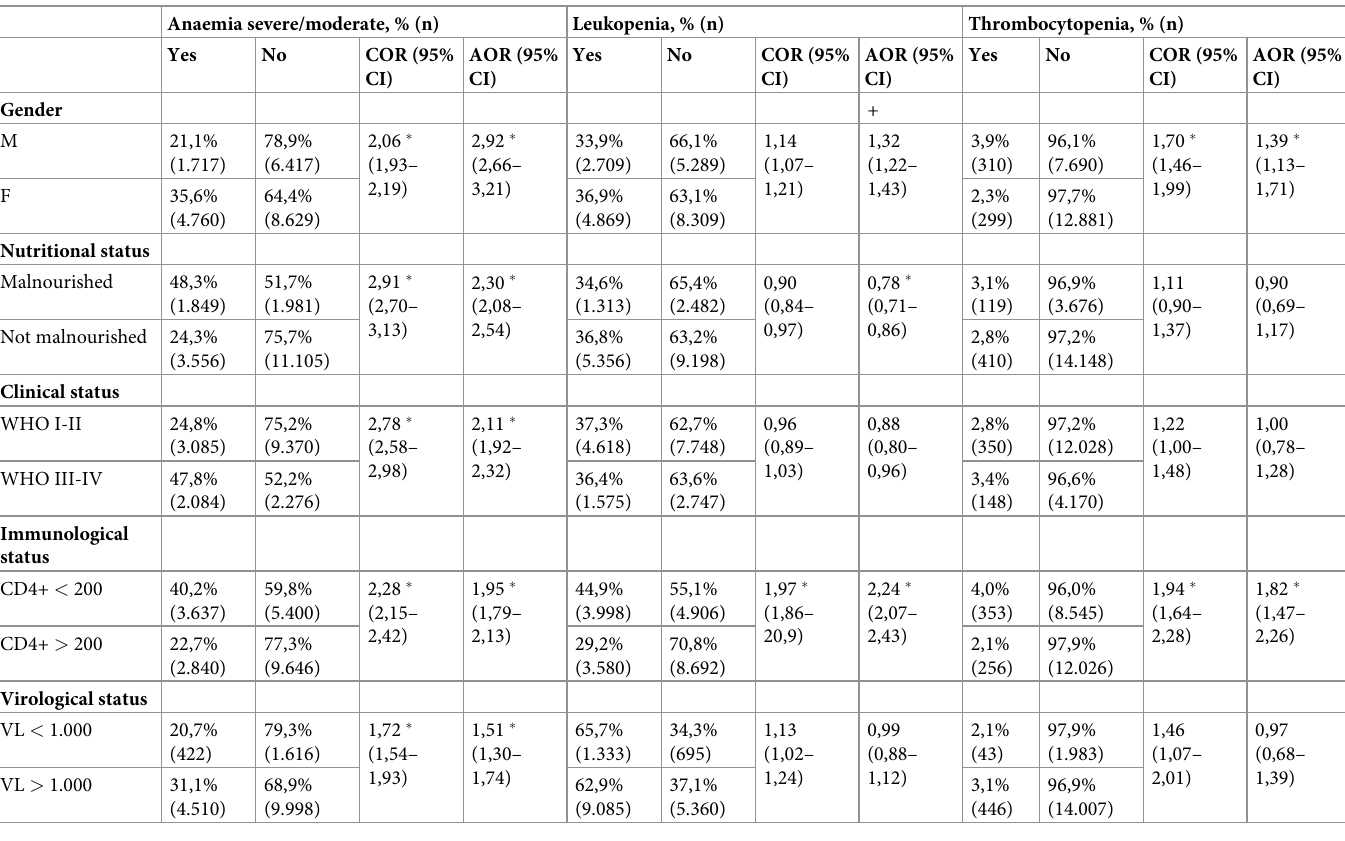
was higher, as illustrated in Table 6. Among those patients who died within one year, 98,2% started ARV treatment, with an average time of therapy of 4,3 (SD ± 9,3) months. In the multi- variate Cox analysis adjusted for BMI, CD4+ count and VL, the early mortality group showed higher rates of anaemia, with a significant difference in the severity of the disease, when com- pared with the group of patients who survived to one year from enrolment (p < 0,001) (Fig 1). The risk of premature death progressively increased with the severity of anaemia: HR 1,425 [95% CI: 1,170–1,737] for mild anaemia, HR 2.271 [95%CI 1.872–2.756] for moderate anaemia and HR 3.406 [95%CI 2.762–4.200] for severe anaemia, as shown in Fig 2 and Table 7.